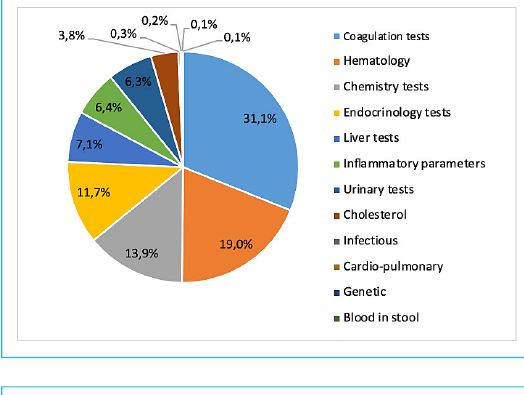
Figure 1: Type of laboratory tests billed during home visits, n = 72,159.